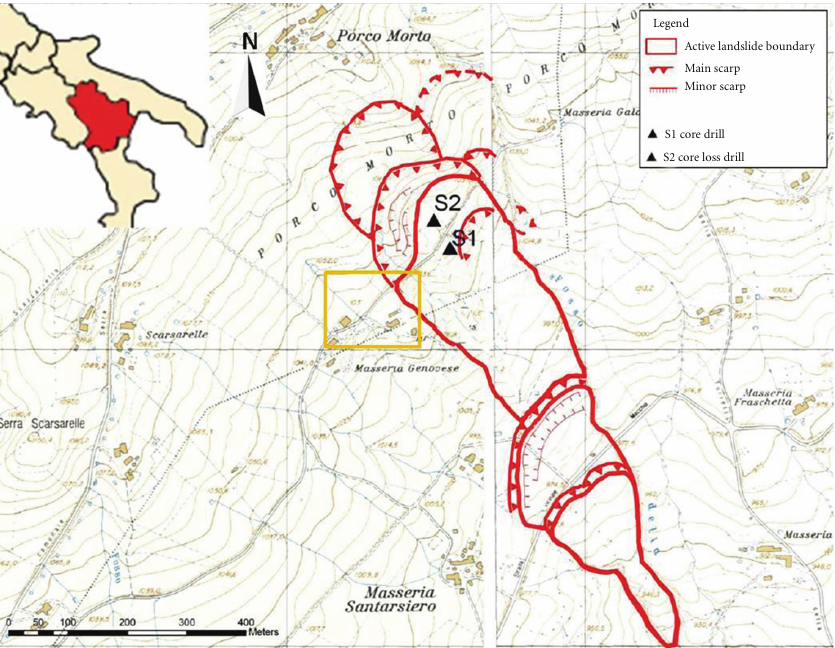
Figure 3: Geomorphologic map of the landslide (from [1] modified), yellow square includes the area where the system was installed.